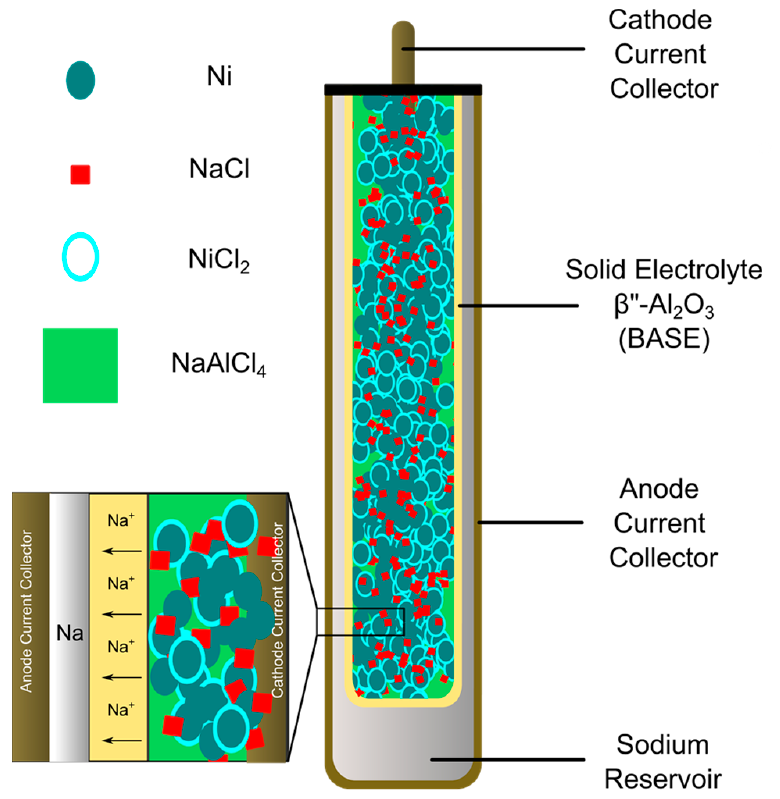
Figure 1. Schematic illustration of a Na-NiCl 2 battery with a tubular β ”-Al 2 O 3 solid electrolyte (yellow). During operation, molten NaAlCl 4 acts as the secondary electrolyte in the cathode to conduct sodium ions between the active materials and the solid electrolyte. Particles of Ni form a conductive network radiating from the cathode current collector. A surface coating of NiCl 2 develops on the Ni particles, as sodium ions migrate across the solid electrolyte to the anode during